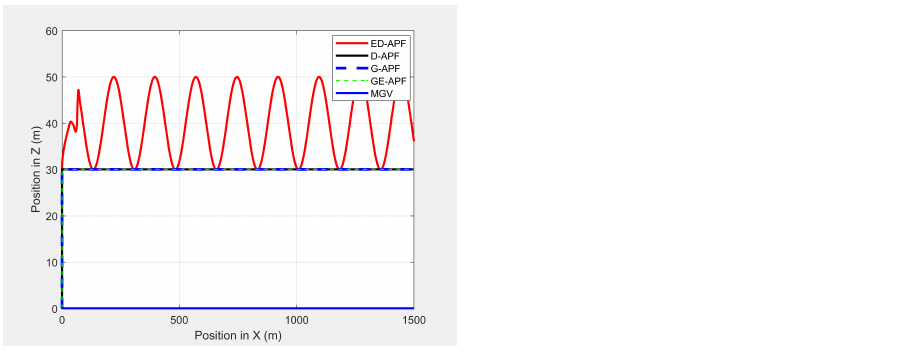
Figure 31. The UAV’s planned path in 2D when following the MGV while moving in an environment with different objects.